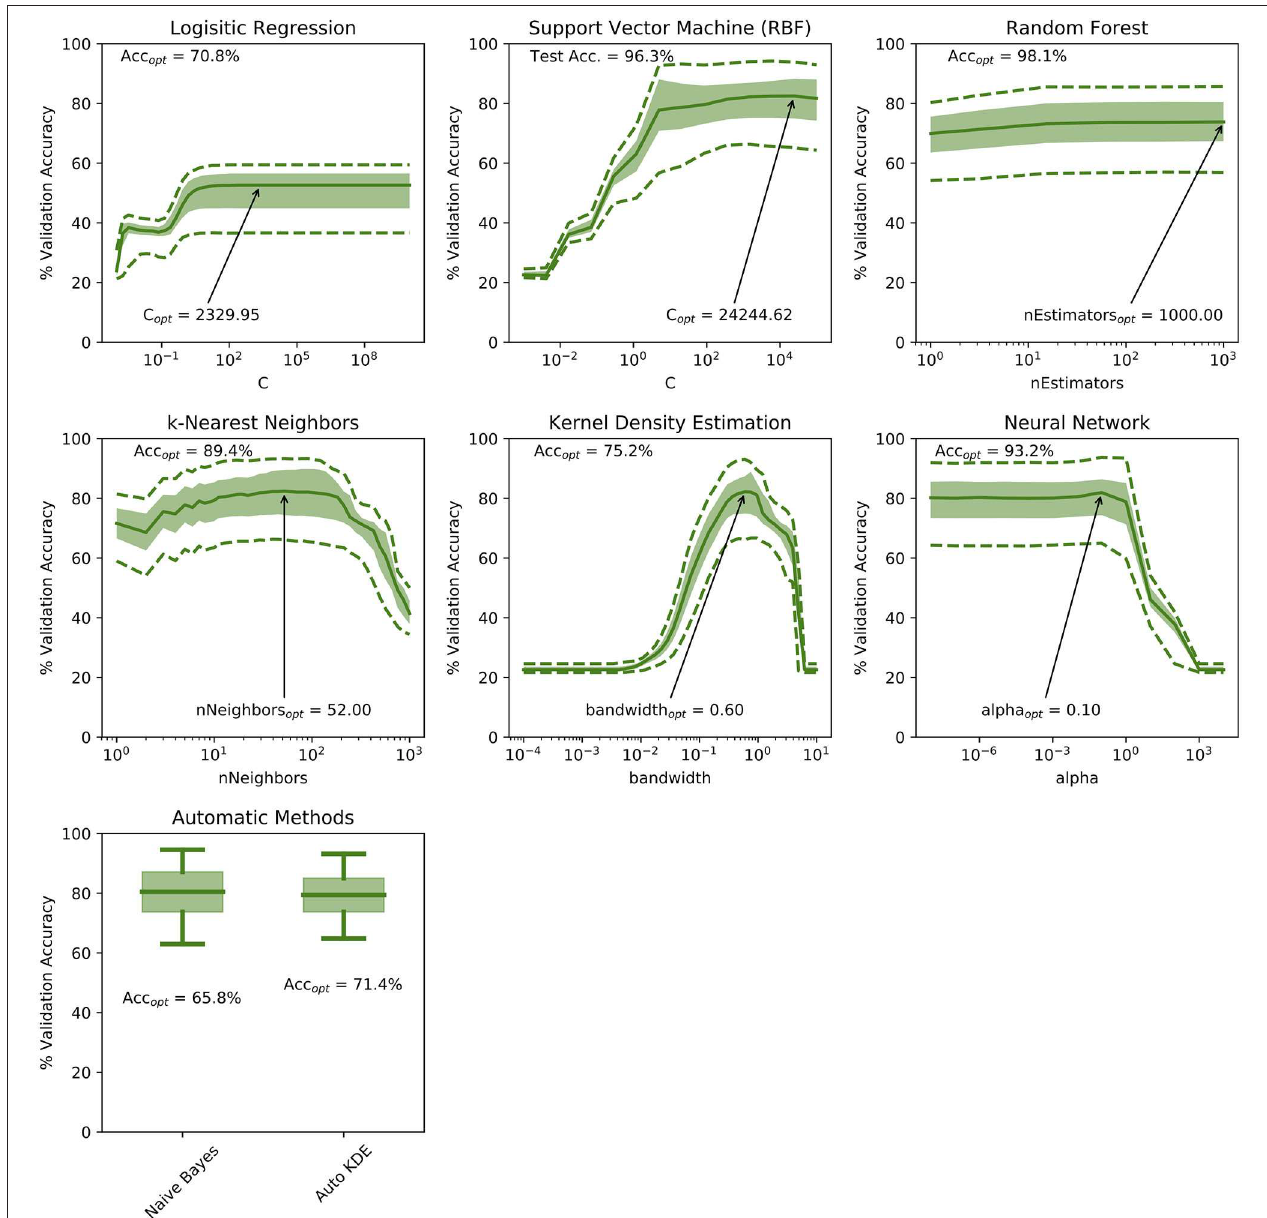
FIGURE 2 | Demonstration of cross-validation accuracies over the range of hyper-parameters tested in this study. For the Kernel Density Estimation and k-Nearest Neighbor methods, an optimum hyper-parameter can be identified. For the remaining techniques, a hyper-parameter limit is identified by the presence of a plateau in the validation accuracy curve. Solid curves represent median values, shaded areas demonstrate the interquartile range and dashed lines represent the 5th and 95th percentiles of the validation accuracy measurements. The optimum hyper parameter is annotated on each sub-plot with the corresponding validation accuracy shown in the